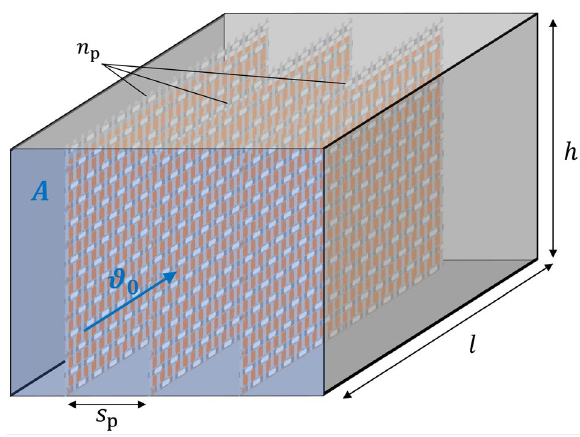
Figure 4. Reactor chamber structure with thin curtains: two carbon fiber fabrics enclosing a perovskite- radioisotope compound granule; multiple curtains flowed longitudinal, and; chamber walls made of